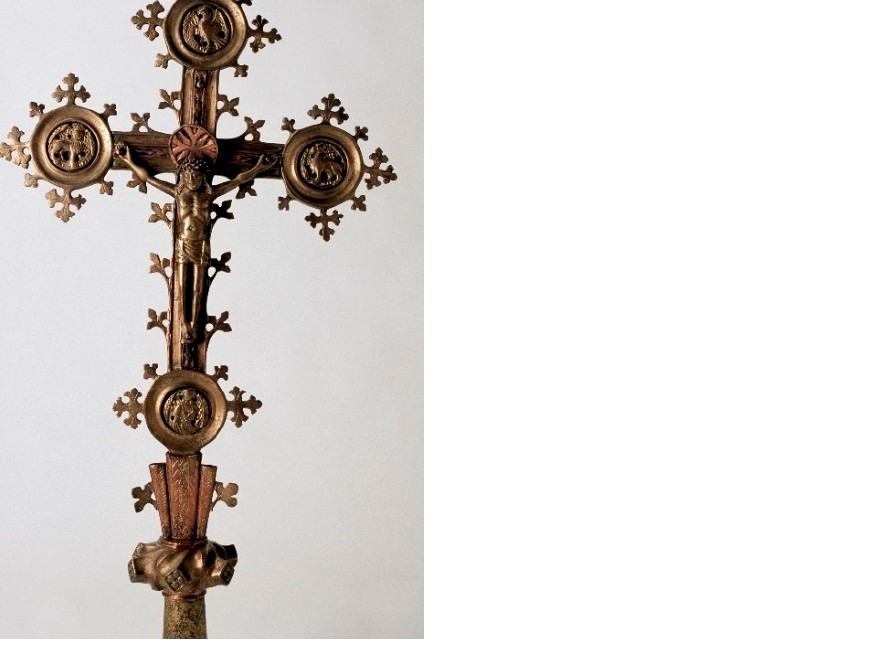
Figure 17. Sheephouse Processional Cross, c.1450. Reproduced by permission © National Museum of Ireland.